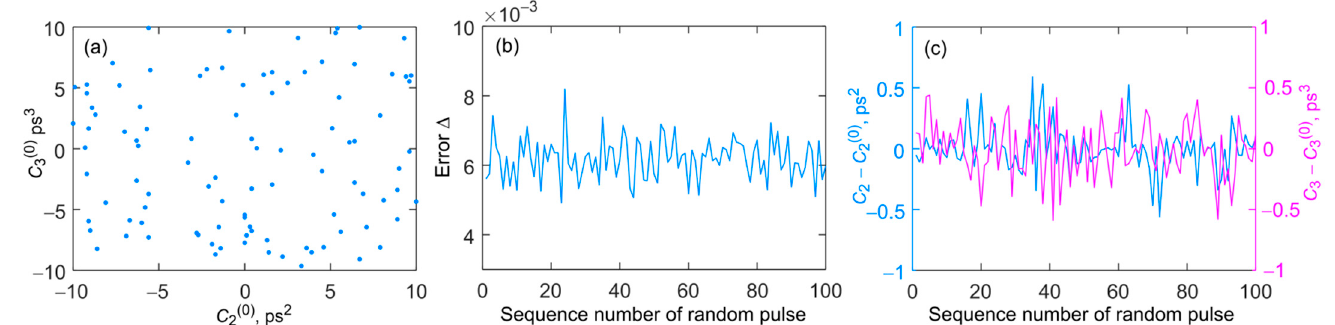
Figure 4. Reconstruction of 100 pulses with noisy sech 2 -shaped spectrum with spectral width FWHM = 0.6 THz and randomly generated spectral phases. Each dot in panel ( a ) indicates polynomial coefficients for a single test pulse. Calculated error Δ for reconstructed pulses ( b ). Difference between reconstructed and original polynomial coefficients of spectral phases ( c ).